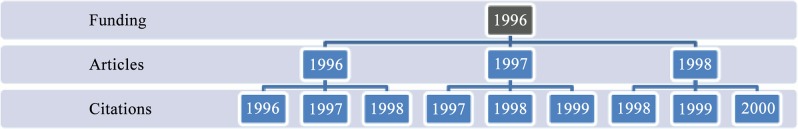
Example of the procedure for counting the citations received by the articles.